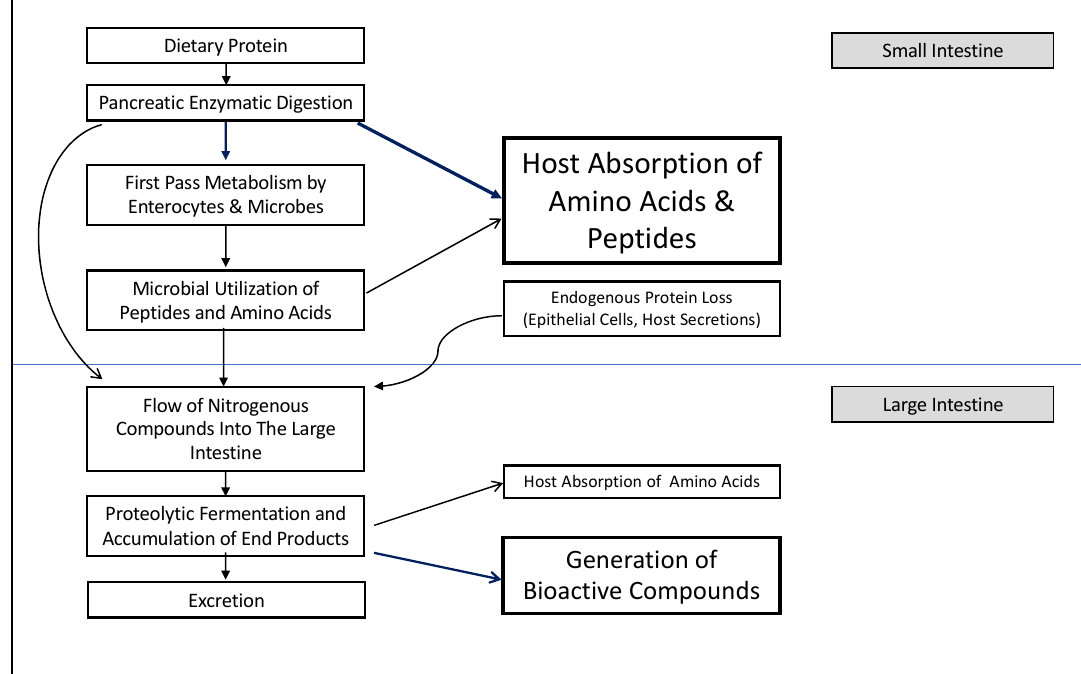
Figure 1. The fate of dietary protein in the gut is determined by a network of metabolic processes including both host and microbial digestion and utilization. The dominant effects for each compartment are bolded and shown with dark blue arrows.